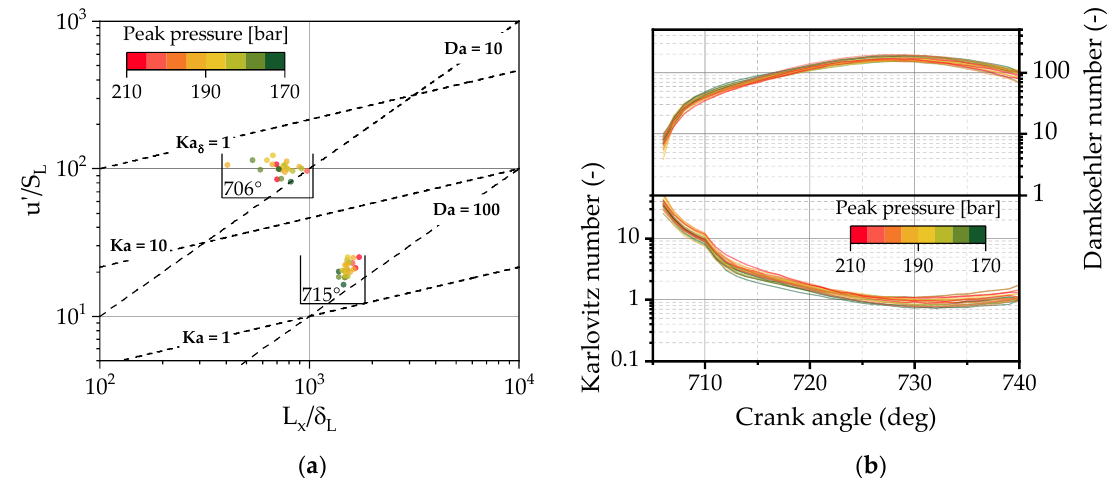
Figure 18. ( a ) Borghi–Peters diagram of the single LES cycles’ dependence on the peak pressure at two different crank angles. ( b ) Damkoehler and Karlovitz number evaluated for every single LES cycle dependent on the peak pressure.